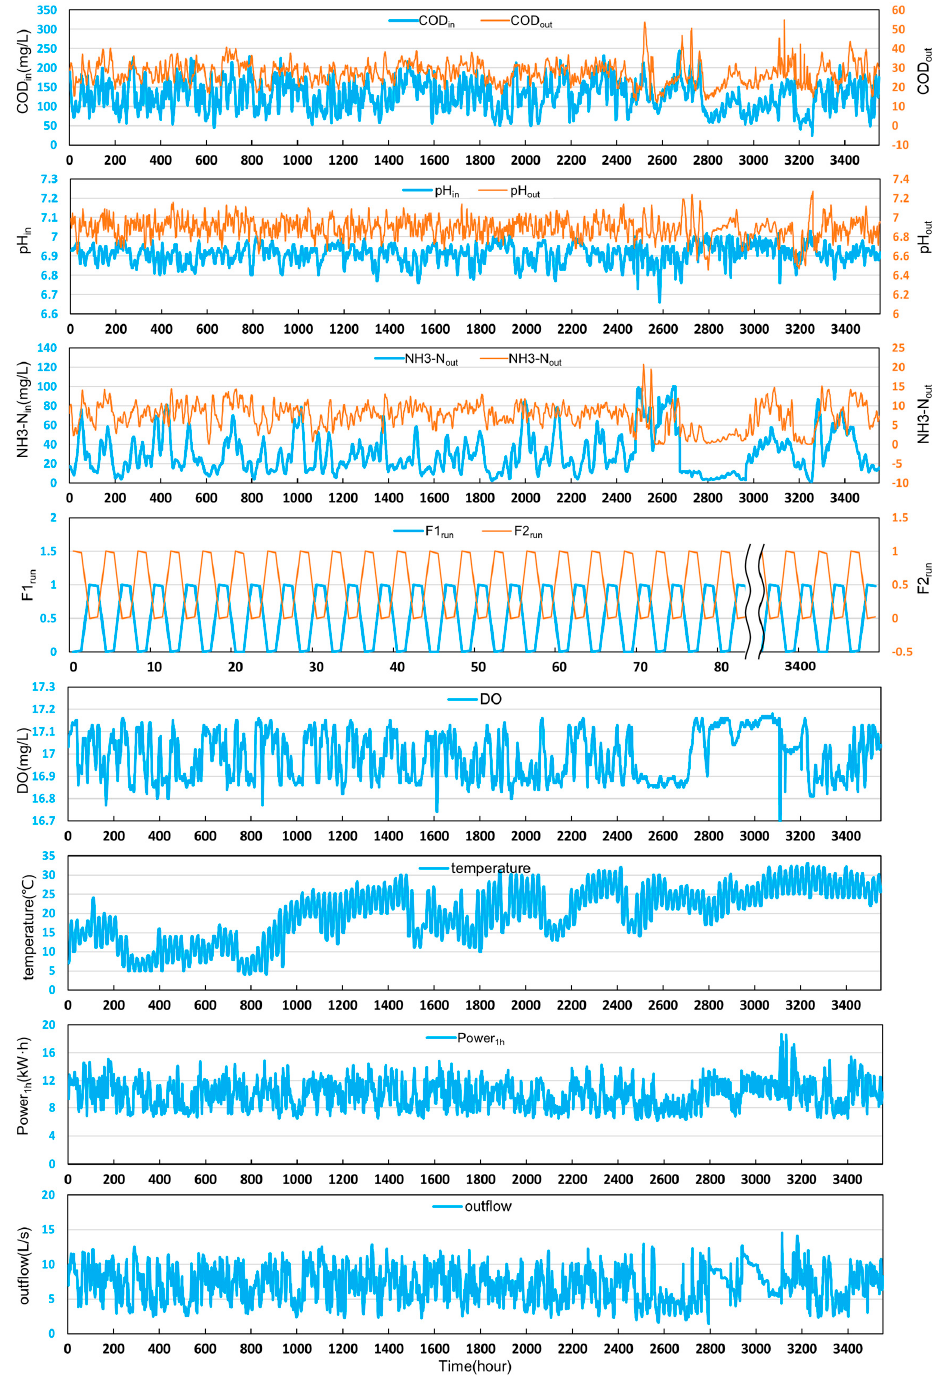
Figure 2. The original values of the 12 water quality parameters measured by sensors from February to June 2022 and used for the preparation of the training and validation sets, including COD in , COD out , pH in , pH out , NH3-N in , NH3-N out , F1 run , F2 run , DO, temperature, Power 1h , and out fl ow.